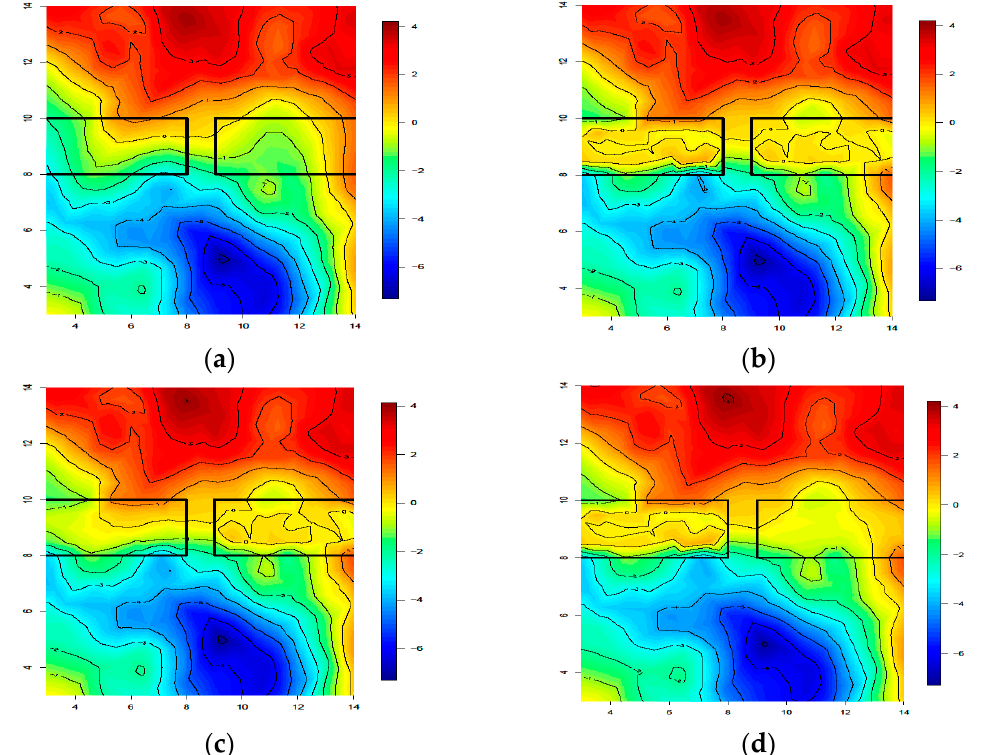
Figure 7. Spatial random fields of different models. ( a ) Spatial random field of the stationary Gaussian model; ( b ) Spatial random field of the barrier model; ( c ) Model spatial random field of the Multi-Barriers Model; ( d ) Spatial random field of the Multi-Barriers Model.